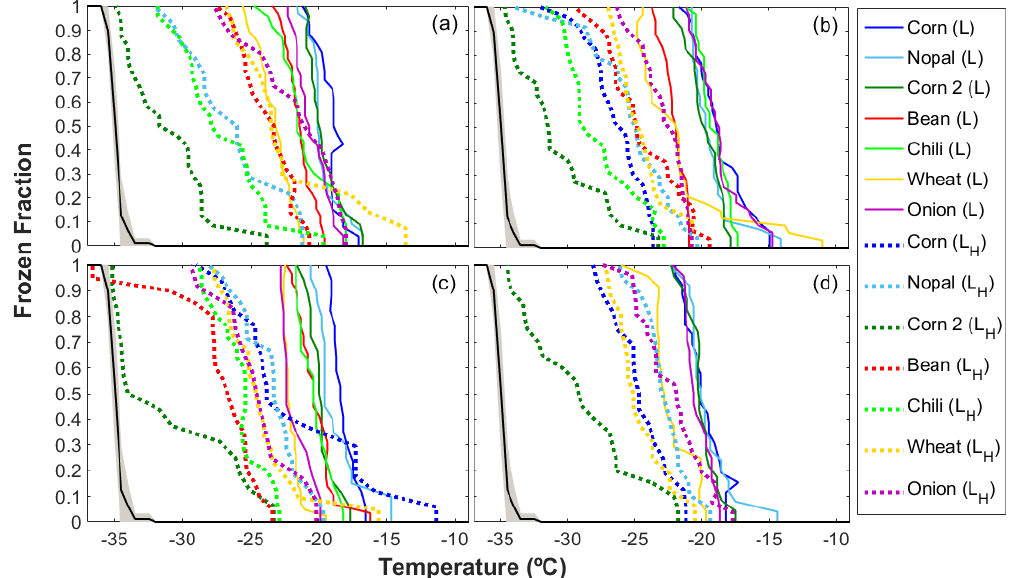
Figure 5. Ice nucleating abilities of agricultural dust particles generated in the laboratory (L) before and after the heat treatment as a function of temperature for particle sizes of (a) 3.2–5.6µm, (b) 1.8–3.2µm, (c) 1.0–1.8µm, and (d) 0.56–1.0µm. The black line depicts the average homogeneous freezing curve. The dashed and solid lines show the results for the heated samples (H) and nonheated samples, respectively. For the heat treatment, the samples were heated at 300 ◦ C for 2h.